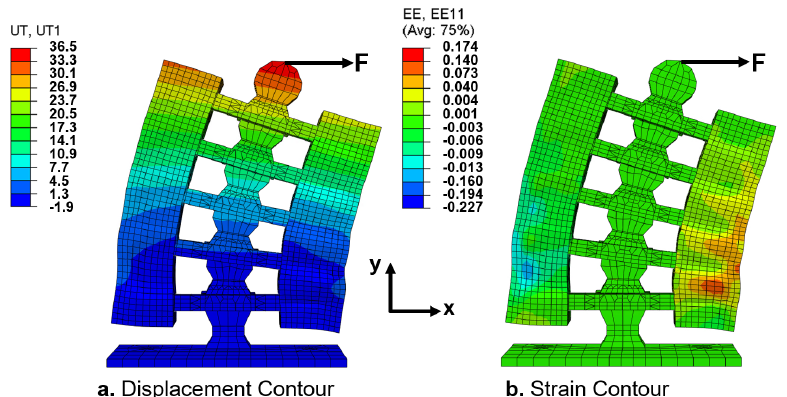
Figure 16. Contours of the displacement in the X -direction ( a ) and of the principle strain, ε xx , due to a 29.4 N force applied to the end of the top rigid segment; ( a ) the maximum displacement (in mm) is φ = 11.0 ◦ , which is 4.4% less than the maximum experimental angle of 11.5 ◦ ; ( b ) the strain is highest in the hyperelastic materials between the rigid segments (ribs), where energy is